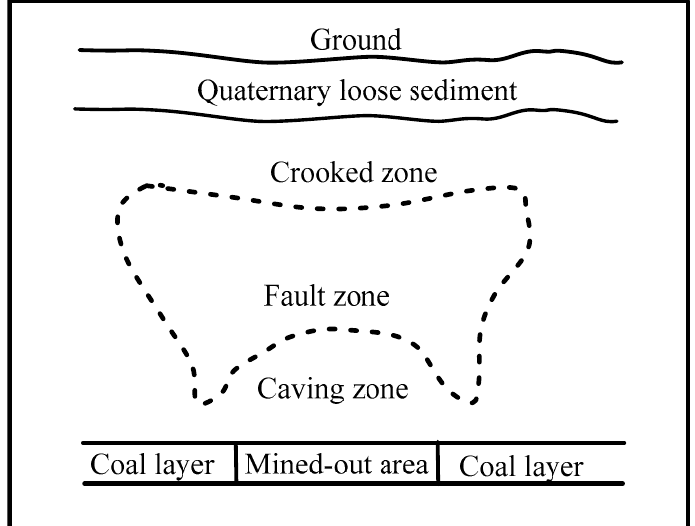
Figure 1. Schematic diagram of typical three zones in mined-out area.